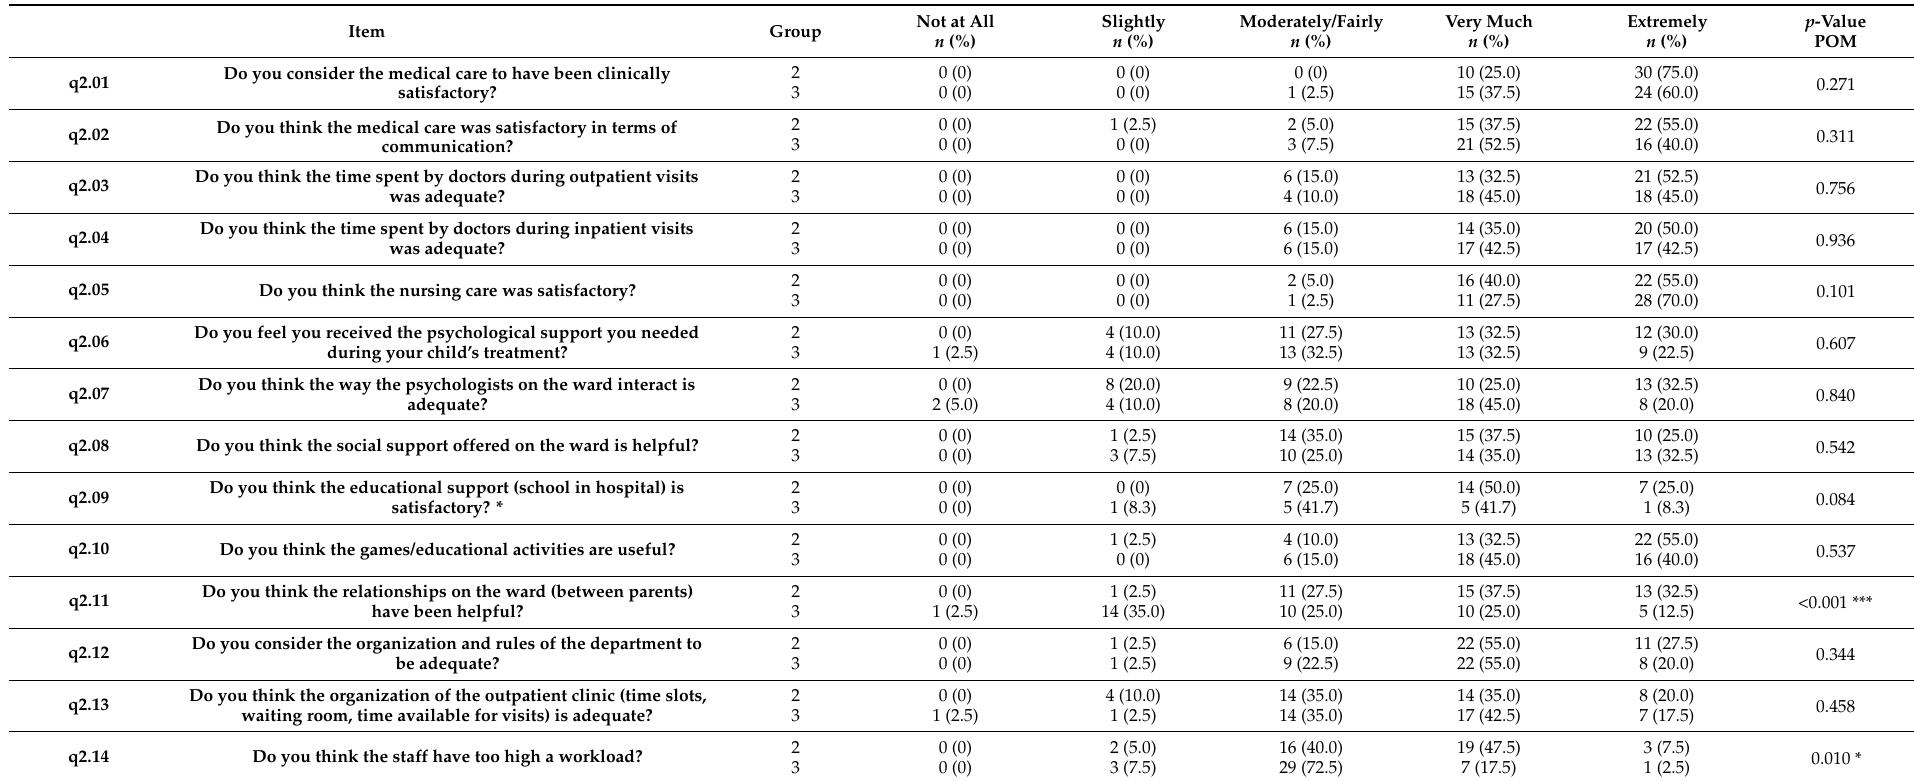
Table 2. Questionnaire 2: results for each pair of items (Groups 2 and